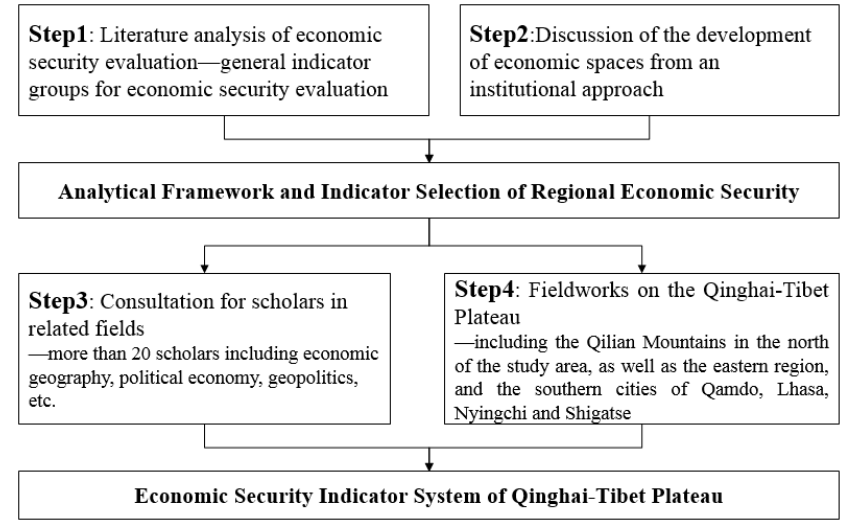
Figure 4. The Construction Process of RES Indicator System of Qinghai – Tibet Plateau.